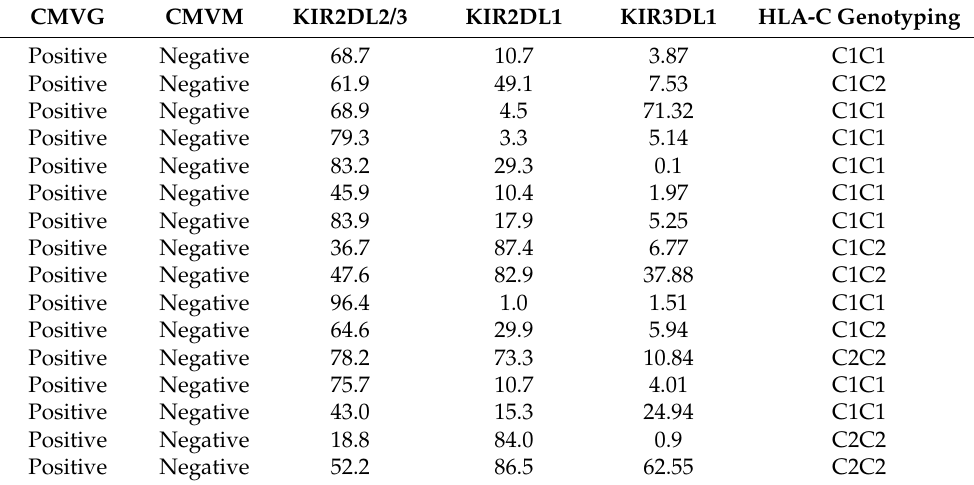
Negative Negative Negative Negative Positive Negative Positive Negative